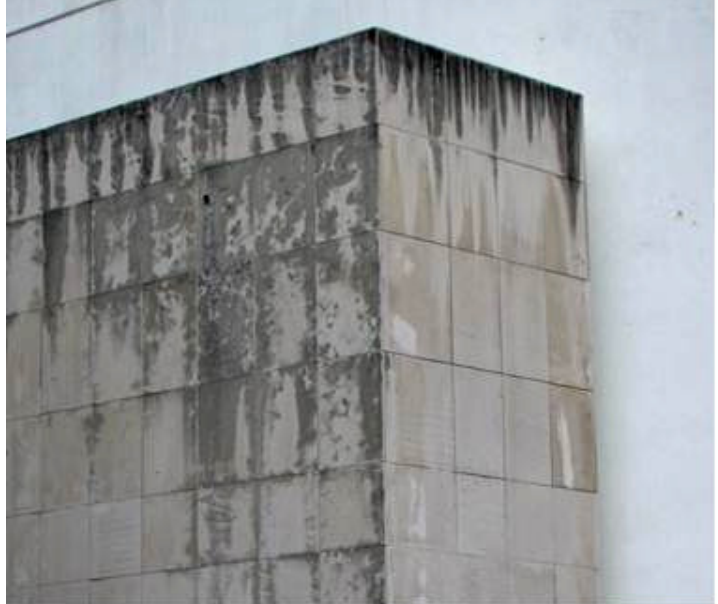
Figure 1. Irregular staining of limestone applied on a recent